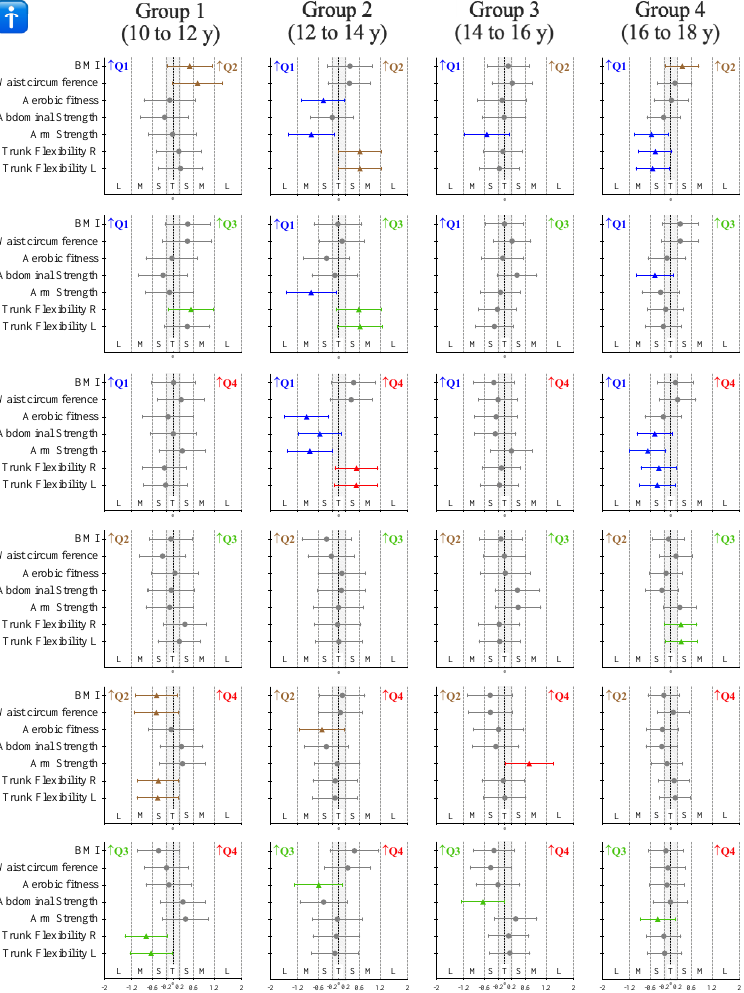
Figure 2. Standardized (Cohen) differences in the considered variables according to the age group for male participants. Error bars indicate uncertainty in the true mean changes with 95% confidence intervals. Abbreviations: Q1 = first quarter, participants born in January, February and March; Q2 = second quarter, participants born in April, May and June; Q3 = third quarter, participants born in July, August and September; Q4 = fourth quarter, participants born in October, November and December. ↑ = means that the participants from that quarter presented higher values. Gray error bars denote unclear results.